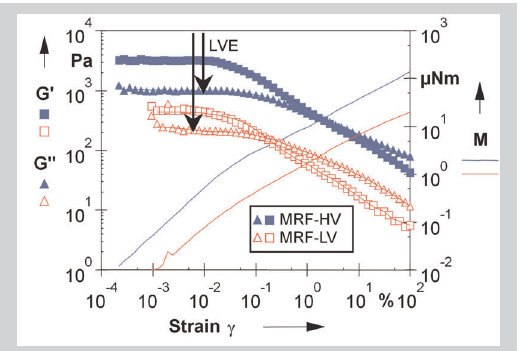
Figure 6-a (right): Amplitude Sweep at w = 10 s -1 showing the storage modulus G’, the loss modulus G’’ and the torque M of MRF-LV and MRF-HV without an external magnetic field H = 0